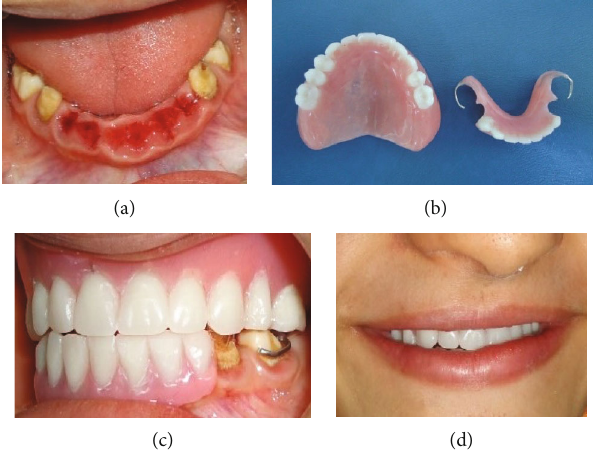
Figure 5: Dental treatment. (a) Extraction of the mandibular incisors and canines. (b) Interim maxillary and mandibular prostheses. (c) Prostheses adjusted in the mouth. (d) Final clinical